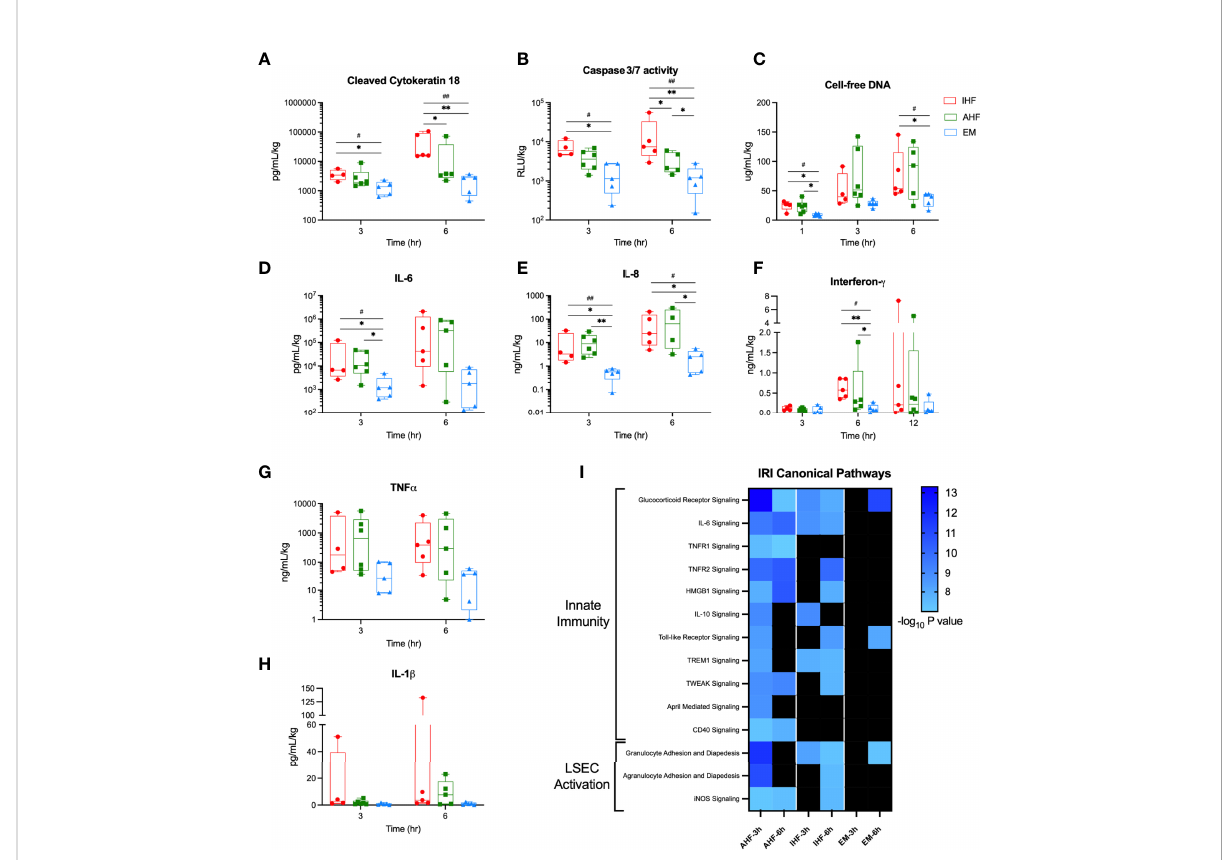
FIGURE 5 Perfusate cell death and cytokine analysis. Addition of emricasan to NMP resulted in signi fi cantly lower perfusate levels of the apoptosis biomarkers (A) cleaved cytokeratin 18 and (B) caspase-3/7 enzyme activity. (C) Cell-free DNA, a DAMP, was signi fi cantly lower in the perfusate of EM livers at 1 and 6 hours. Levels of pro-in fl ammatory cytokines (D) interleukin-6 (IL-6), (E) interleukin-8 (IL-8), and (F) interferon- g were also signi fi cantly lower in EM livers compared to control groups. Perfusate levels of (G) tumor necrosis factor- a (TNF- a ) and (G) interleukin-1 b (IL-1 b ) were qualitatively lower but did not reach signi fi cance. I) Heatmap of canonical pathways involved in ischemic-reperfusion injury (IRI). The signi fi cance threshold was set to -log10 P value > 7 for comparison of 3- and 6-hour gene sets to the pre-perfusion (0 hour) baseline for